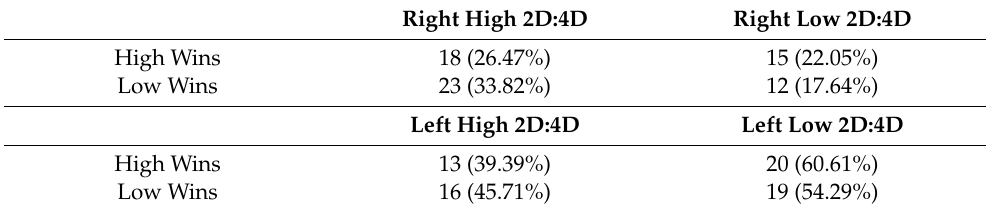
Table 2. Association between prenatal androgenization and winning outcome.